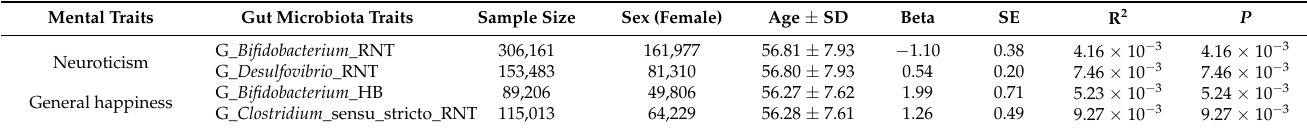
Table 1. The associations between gut microbiota traits and mental